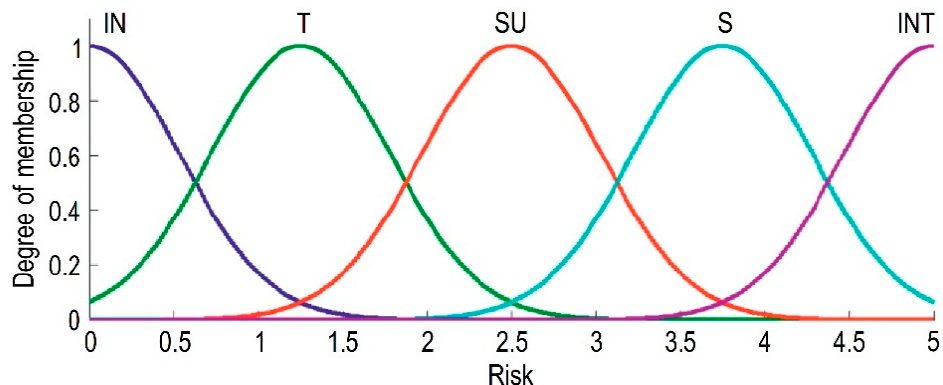
Figure 5. Membership function for the risk level.